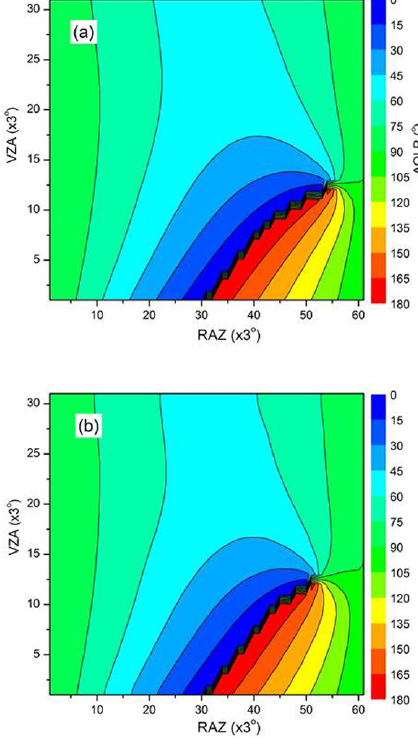
Fig. 15. Same as in Fig. 14, but for AOLPs at the wavelengths of (a) 470nm and (b)